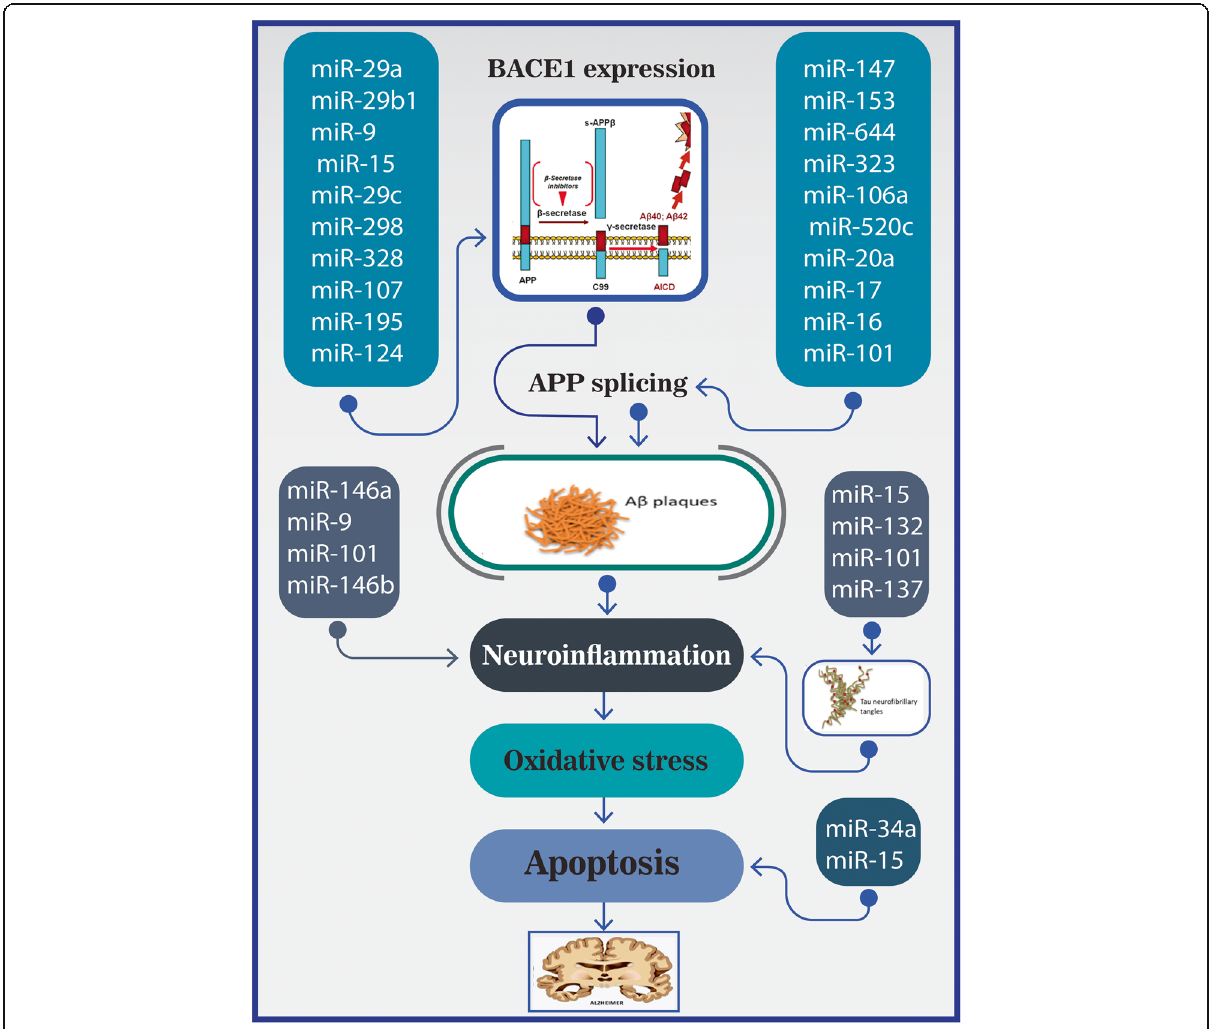
Fig. 1 Micro RNAs dysregulation in Alzheimer disease. Multiple micro RNAs are involved in different pathogenic mechanisms of Alzheimer ’ s disease (modulating the activity of β -secretases, APP splicing, neurofibrillary tangles, neuroinflammation, or apoptosis). APP: amyloid precursor protein, BACE1: β -site APP cleaving enzyme